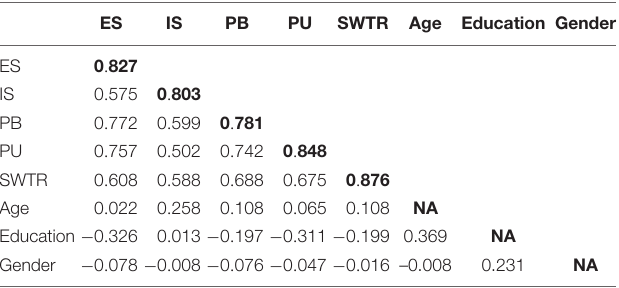
FIGURE 2 | Structural model